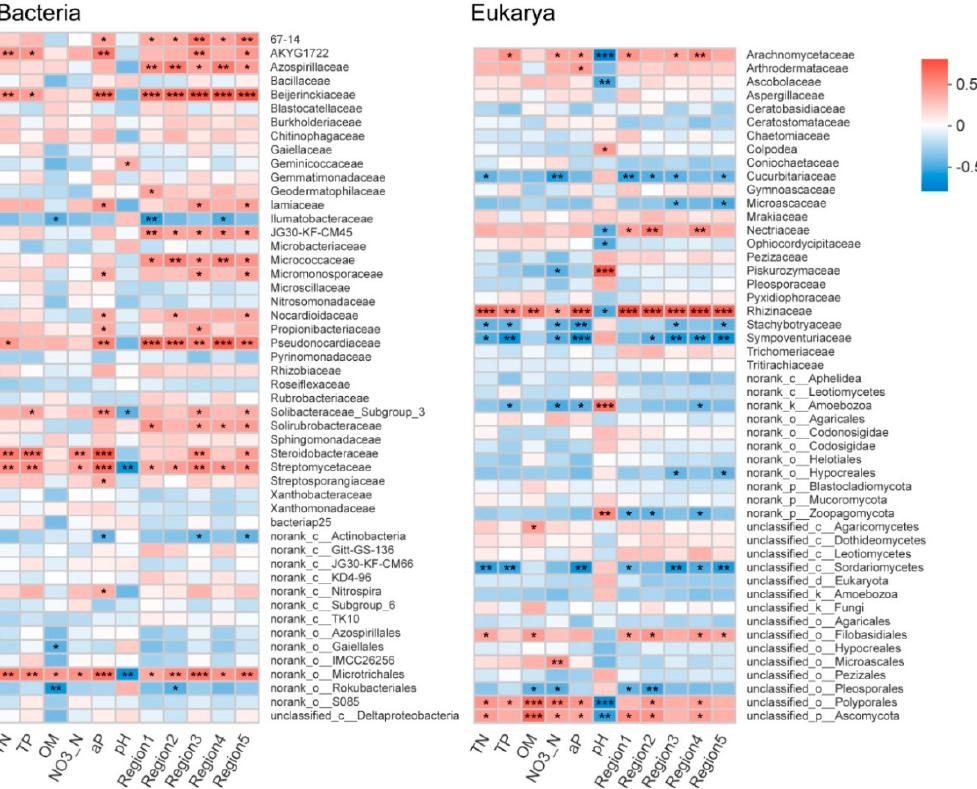
Figure 7. Spearman’s correlations between environmental factors, soil DOM, and microbial taxa.